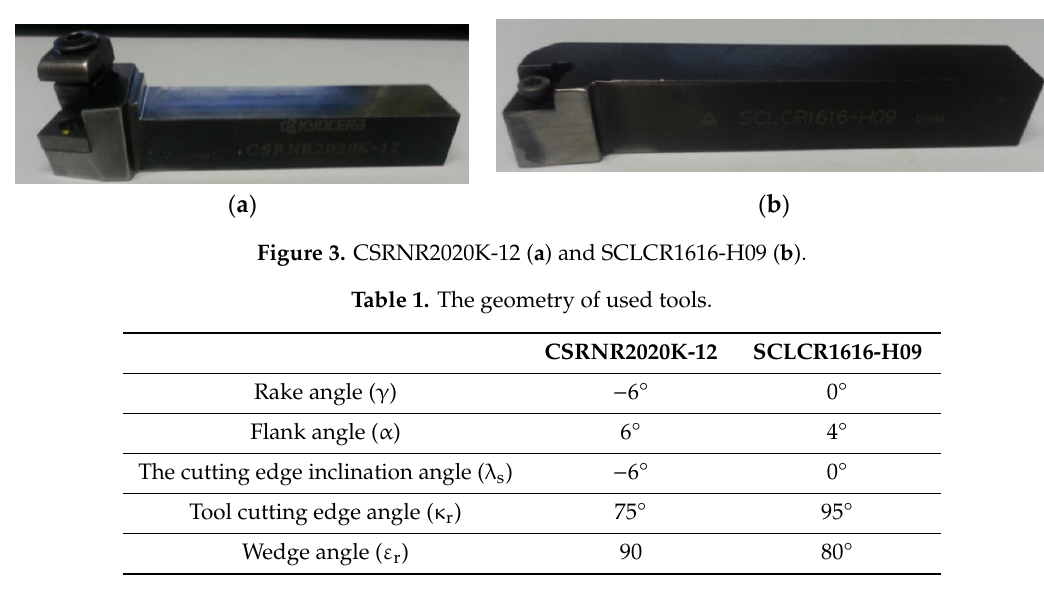
Figure 2. Application of experimental tool ( a ) and tool for preparation of surface ( b ).